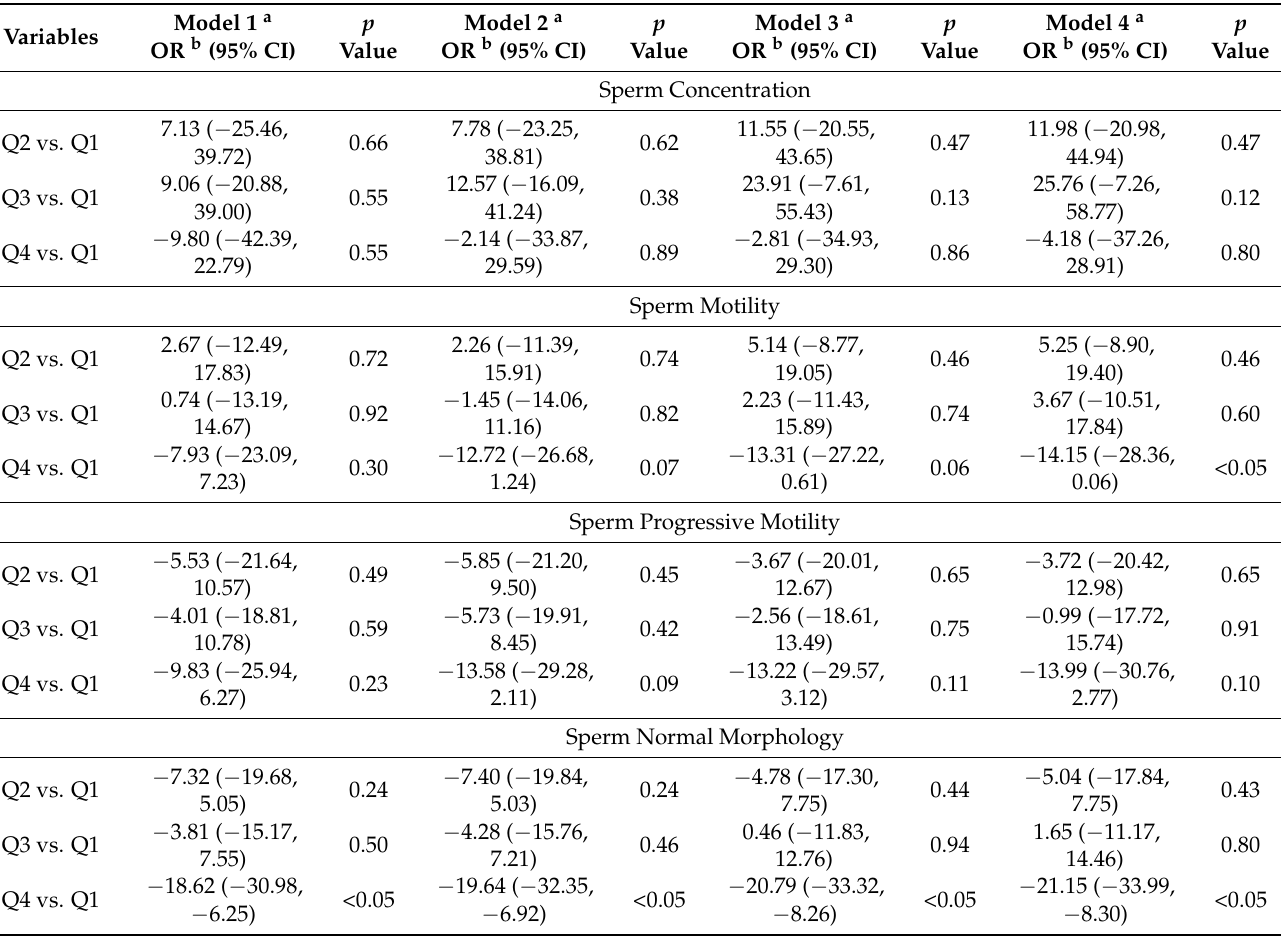
Table 3. Association between quartiles of serum total bilirubin and sperm